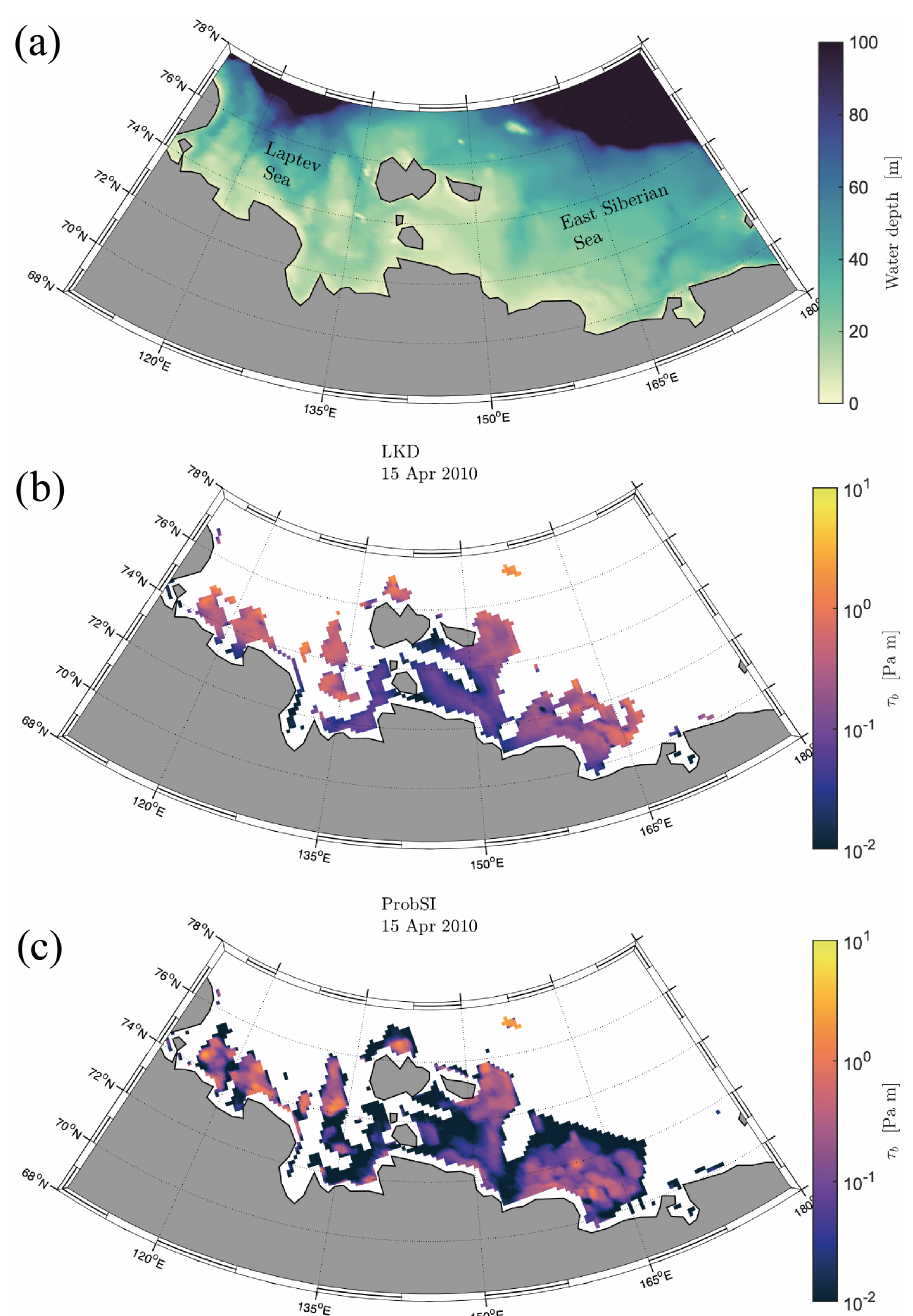
Figure 7. Water depth (a) and basal stress due to seabed–ice interaction in the Laptev and East Siberian seas on 15 April 2010 for the LKD (b) and ProbSI parameterizations (c)